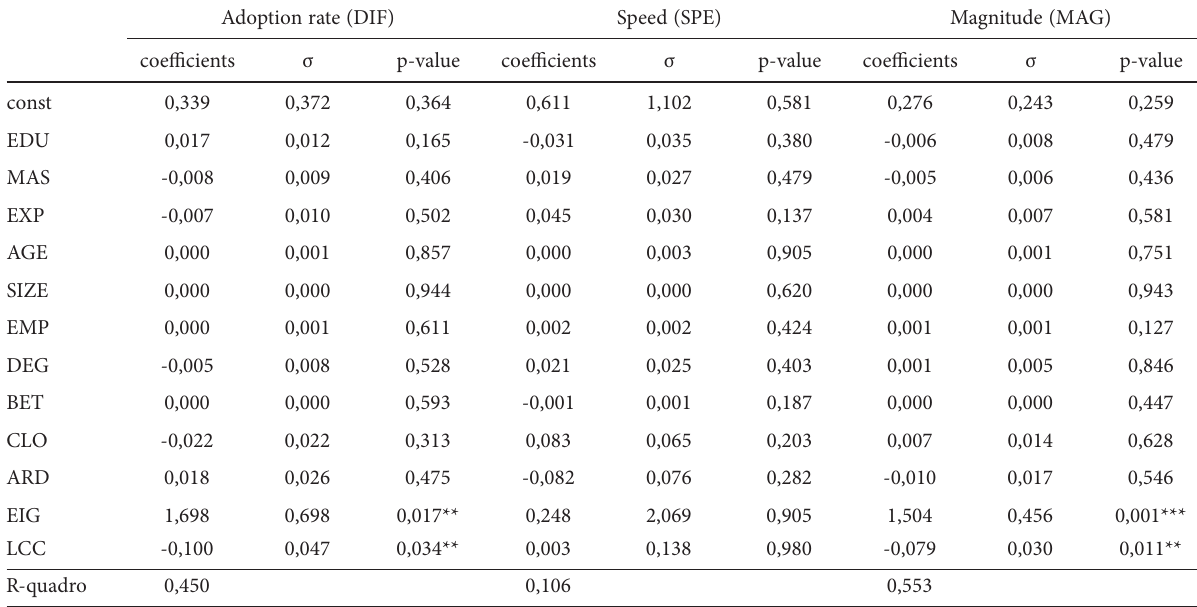
Table 5. The results of the regression